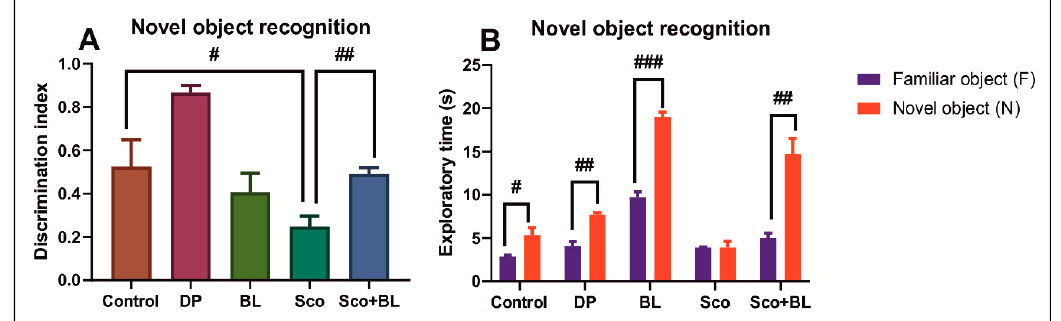
Figure 4. Behavioral analyses for the novel object recognition (NOR) test. ( A ) represents the graph for the discrimination index in different groups; ( B ) represents the graph for the exploratory time (s) in different groups. Data are means ± S.E.M. ( n = 5) and statistical analysis by one-way ANOVA followed by Tukey’s post hoc analyses: ( A ) Control vs. Sco: # p < 0.01; Sco vs. Sco + BL: ## p < 0.001; ( B ) # p < 0.01; ## p < 0.001 and ### p < 0.0001.